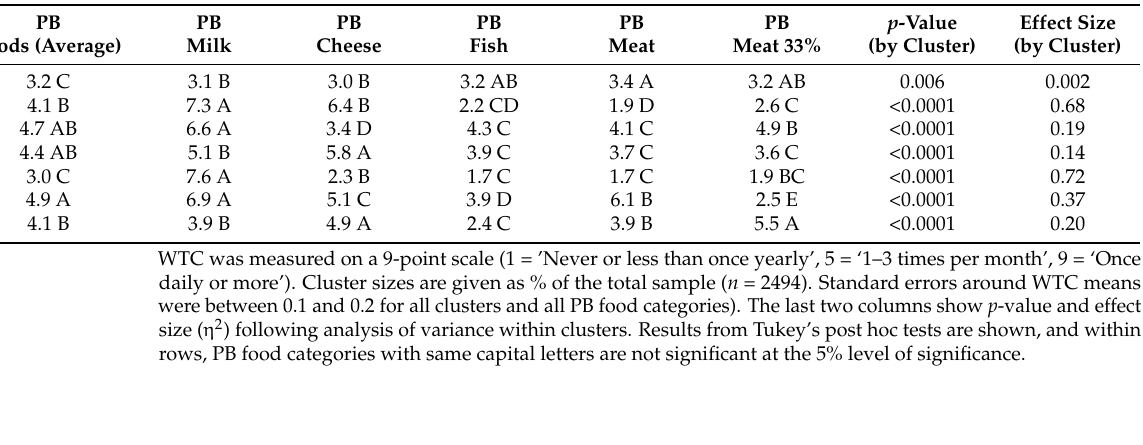
Table 2. Mean willingness to consume (WTC) ratings by plant-based (PB) food category for the 7-cluster solution based on the aggregate sample ( n =